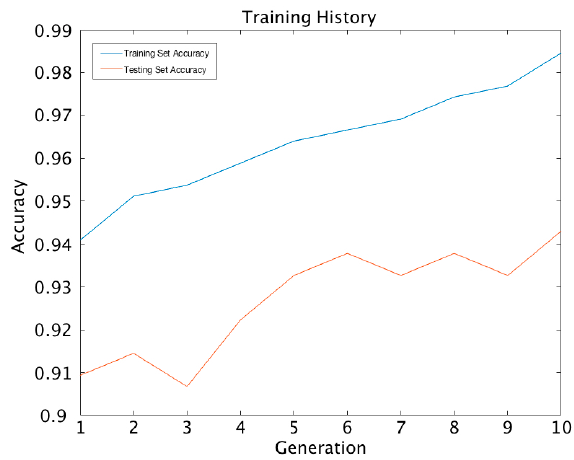
Figure 5. G-ELM Training History at v b = 0.1, v h = 0.3. Table 2. Iterations for each generation of conditions